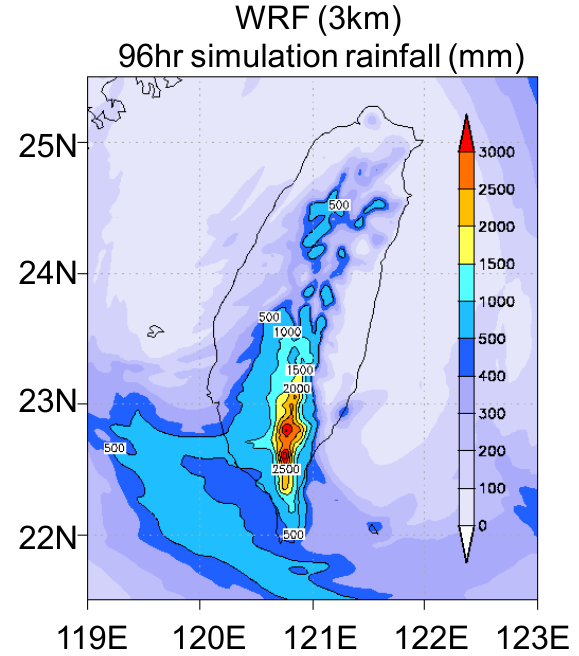
Fig. 6. The simulation accumulated rainfall during 00:00UTC 06 to 00:00UTC 10 August 2009 by WRF